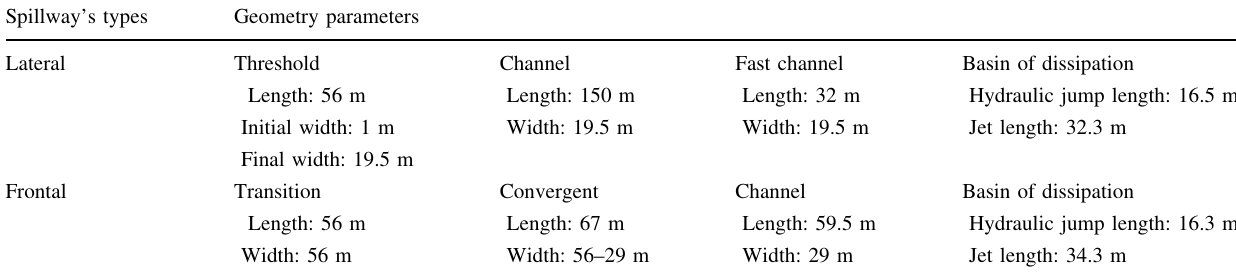
Table 5 Geometry parameters of spillways Spillway’s types